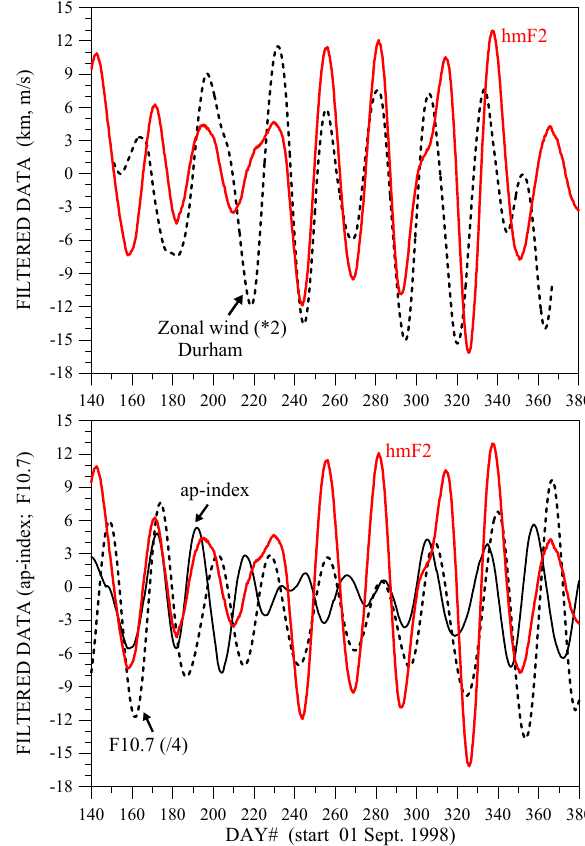
Fig. 7. The 27-day filtered zonal wind data at Durham (black dashed line) and hm F2 at Millstone Hill (red line) observed in the interval betweenday numbers 140 and 380 (shown in the upper plot) and the 27-day filtered A p -index (black solid line), F10.7 (black dashed line) and hm F2 (red line) in the same time interval (lower